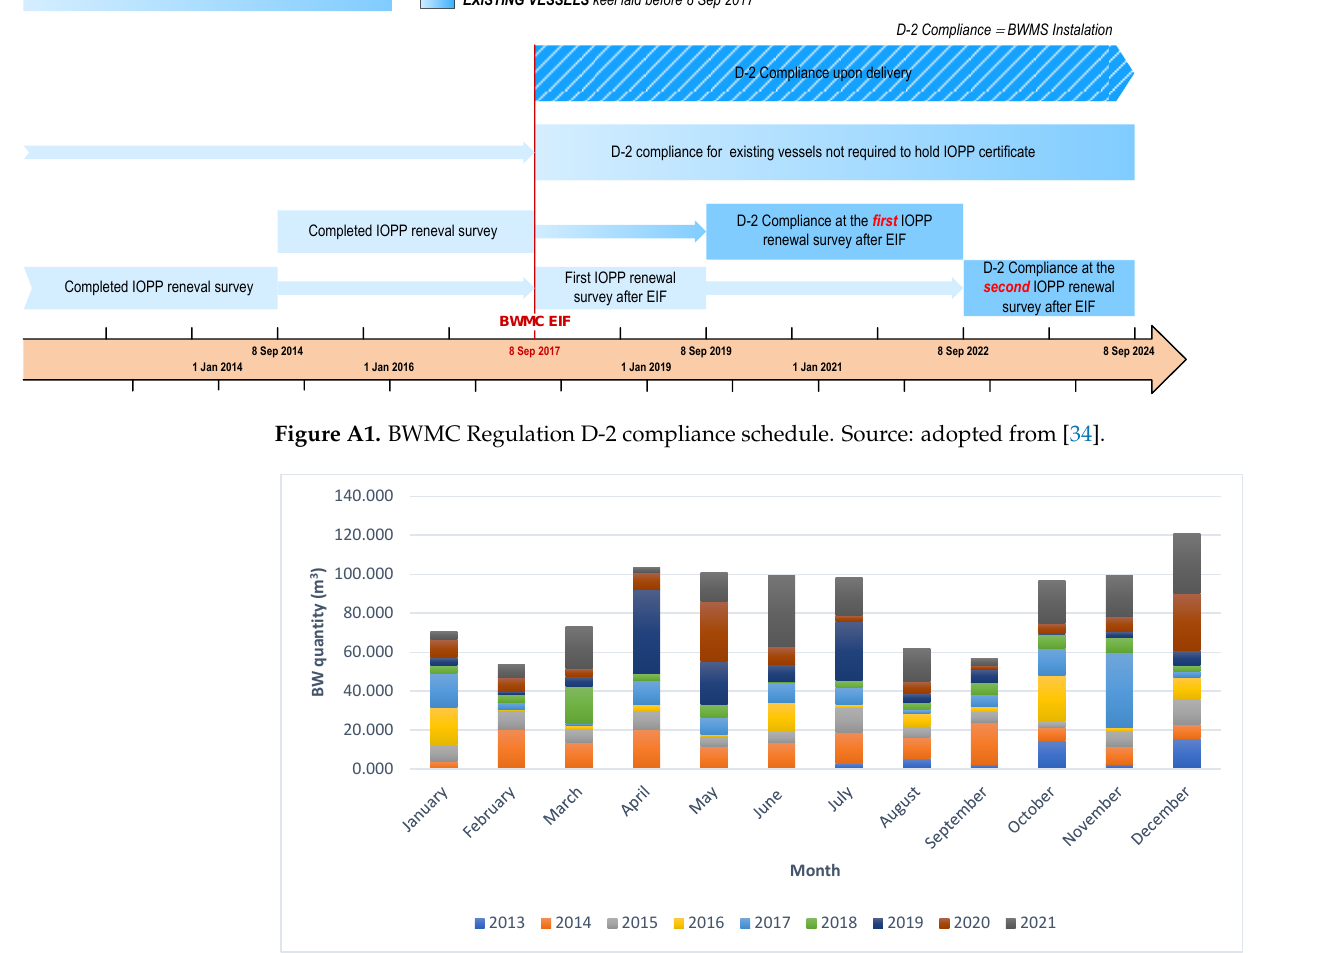
Figure A2. BW quantities discharged in the Port of Ploče by month.